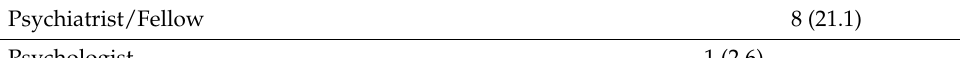
4 of 12 Table 1. Study sample characteristics ( n = 38).